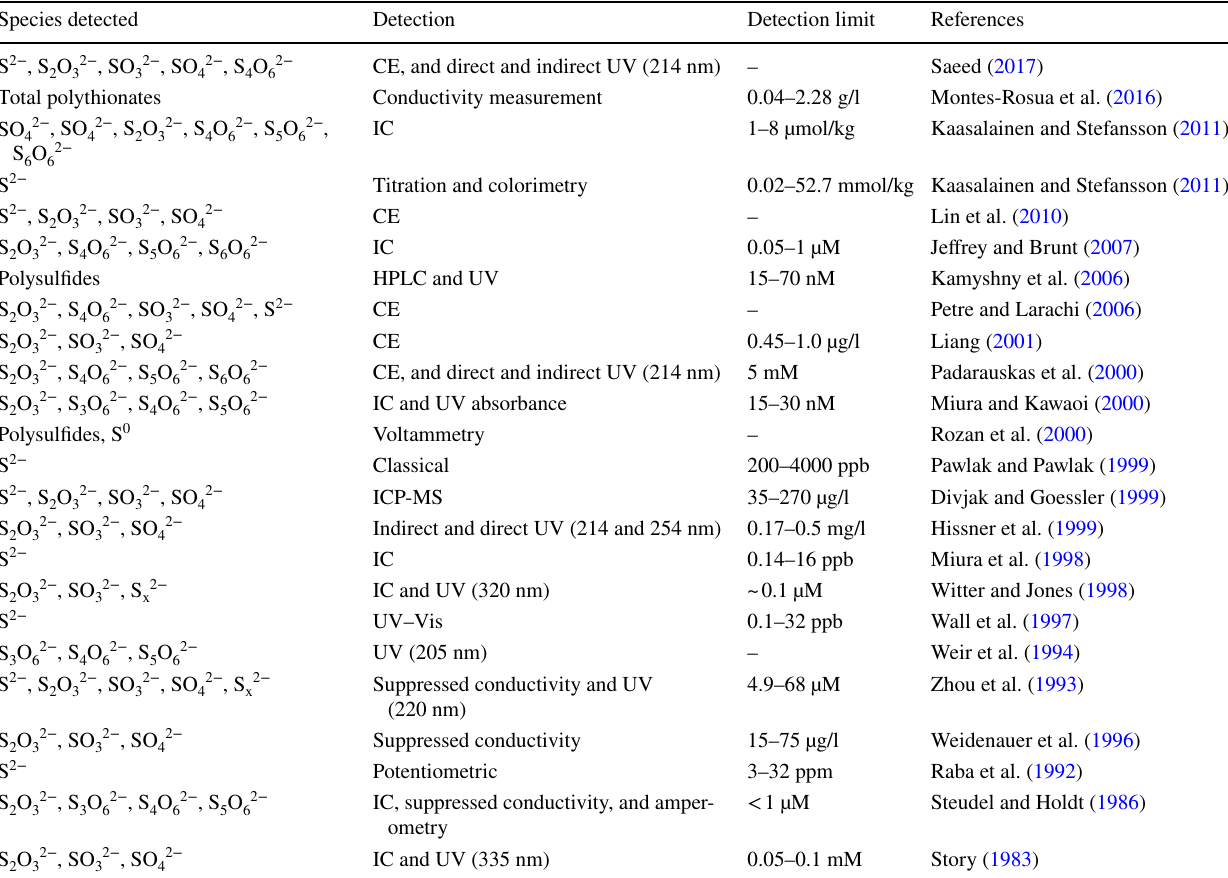
Table 2 Analytical methods for the determination of inorganic sulfur species in aqueous mixtures Species detected